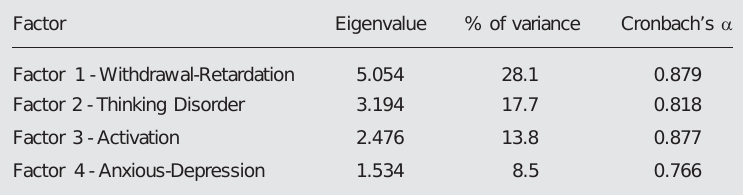
Table 2. Internal consistency for BPRS